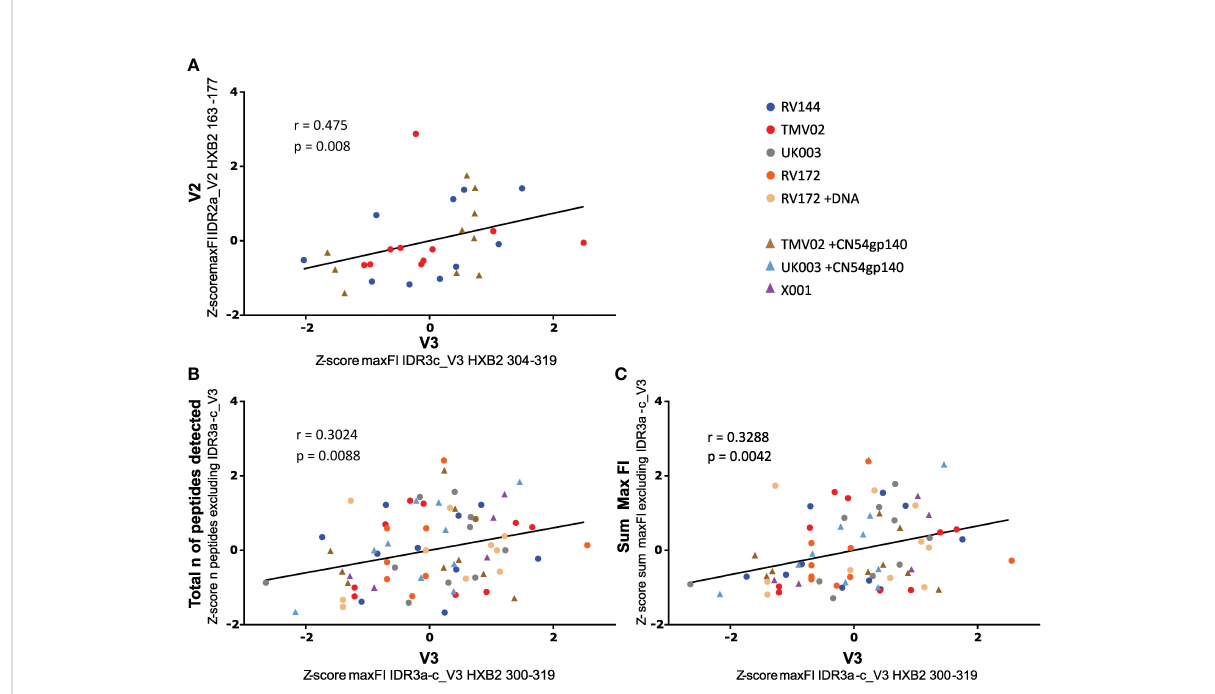
FIGURE 5 Impact of V3 detection on V2 tip and total Env reactivity. Scatter plots depict the relationship between the strength of V3 IgG recognition and (A) V2 detection, (B) the total number of peptides detected, and (C) overall Env detection. Data were Z normalised (mean of 0, standard deviation of 1) to allow comparison of all trials. A Spearman correlation analysis was used to calculate the statistical relationship. (A) Correlation of the intensity of IDR3c_V3 IgG targeting with IDR2a_V2 recognition. For the scaled data, the r-value was: 0.475, the p-value was: 0.008 and the 95% CI calculated by bootstrapping was 0.1273 to 0.7187. V2_IDR2a and V3_IDR3c are represented by one single peptide each. Only data of study participants from studies with both responses (RV144 and TMV02) are plotted. (B) Correlation of the FI values of the whole IDR3_V3 with the total number of Env peptides detected excluding the IDR3_V3. The r-value was: 0.3024, the p-value was: 0.0088 and the 95% CI calculated by bootstrapping was 0.07250 to 0.5018. (C) Correlation of the FI values of the whole IDR3_V3 with the total Env detection strength bar the IDR3_V3. The observed r-value was: 0.3288, the p-value was: 0.0042 and the 95% CI calculated by bootstrapping was 0.1016 to 0.5234. In (B) and (C) the max FI values for the three IDRs belonging to V3 (IDR3a-c) were summed up per patient. The individual studies are differentiated by colour, with each symbol representing one participant. The line indicates the linear fi t of the data. Participants whose regimen included CN54gp140 are symbolised by triangles, all others by